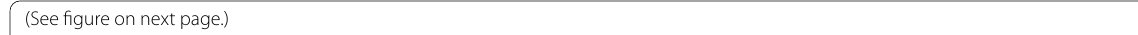
DMSO (equal volume solvent of rapamycin) and high +